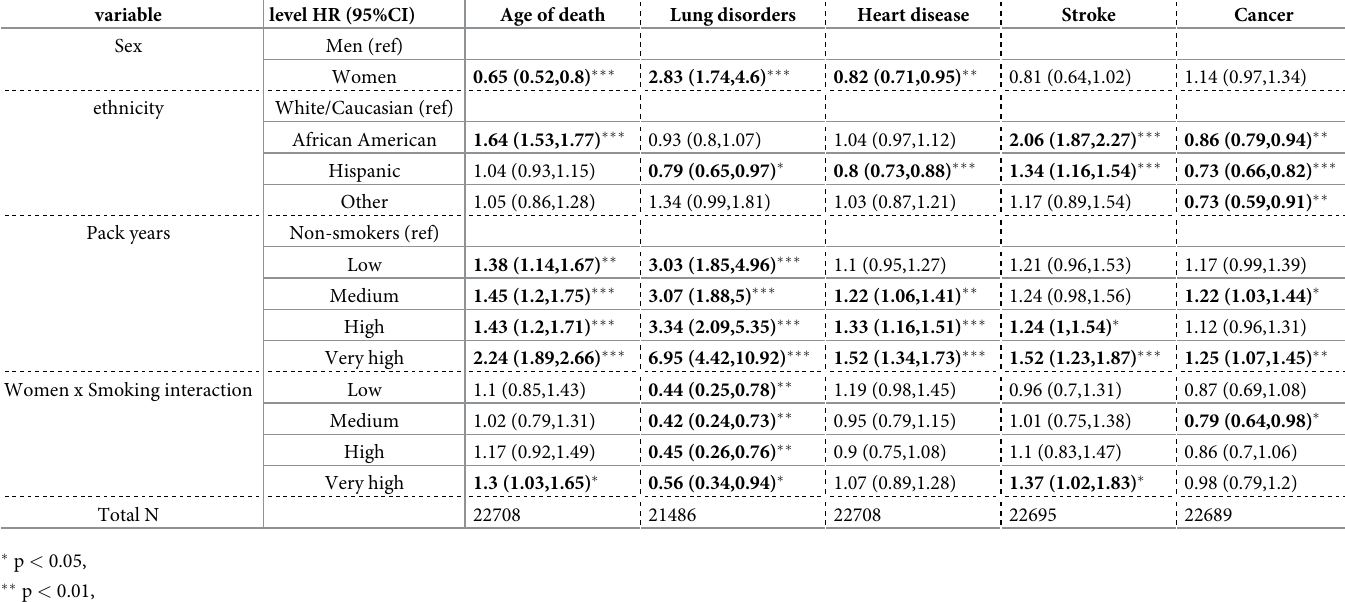
Table 1. Hazard ratios for age of death, and age of onset of lung disorders, heart disease, stroke and cancer according to lifetime smoking level and the interaction with sex.